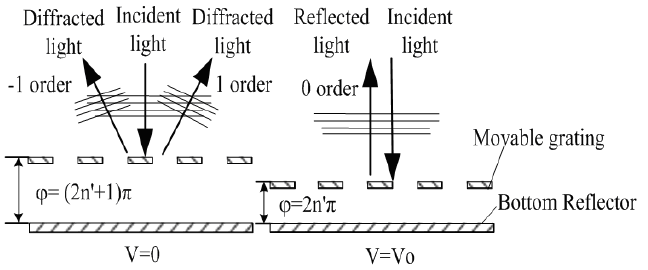
Figure 2. The operating principle of the GLM.